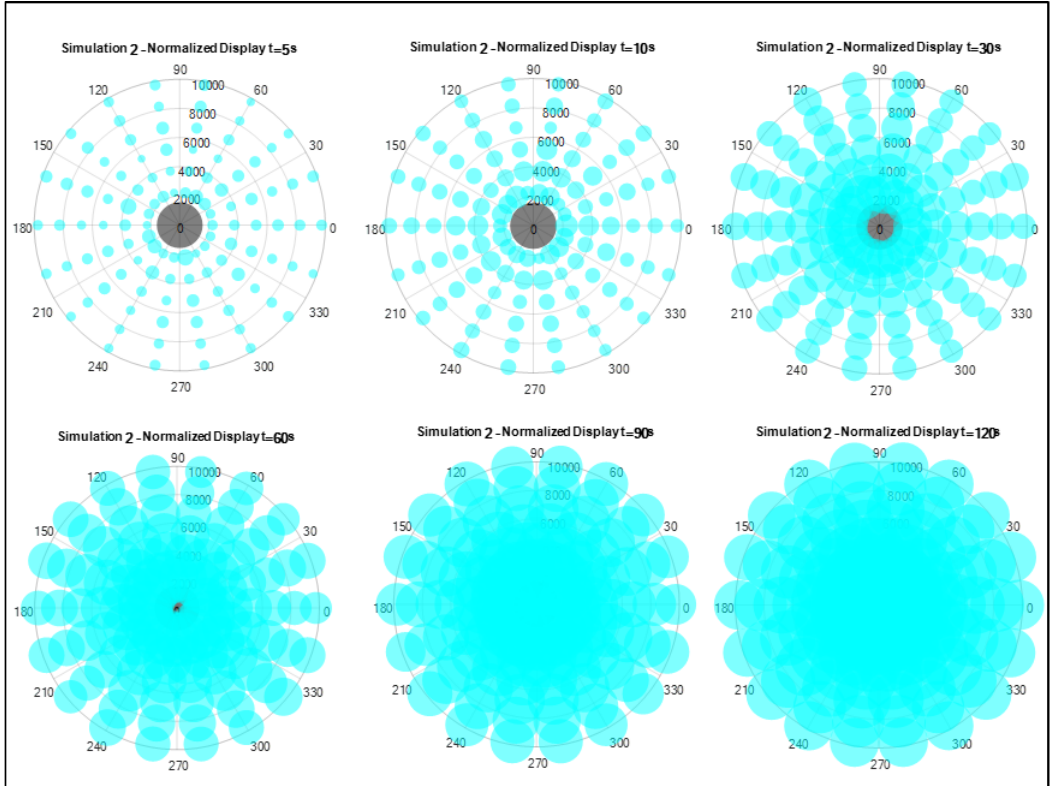
Figure 5. Simulation 2 — changes in the time.